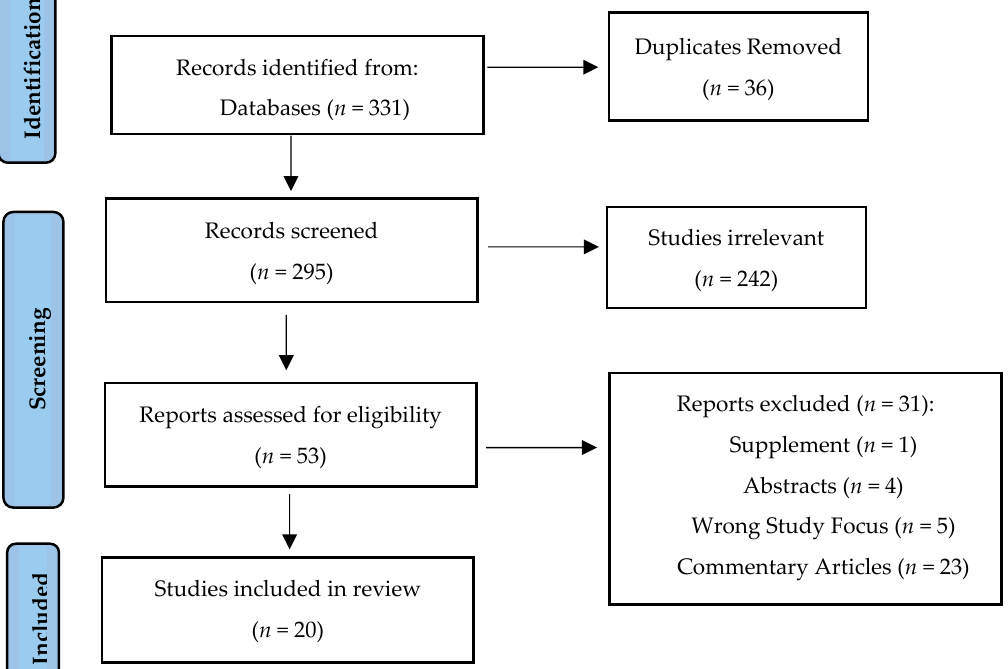
Figure 1. Systematic review article outline.